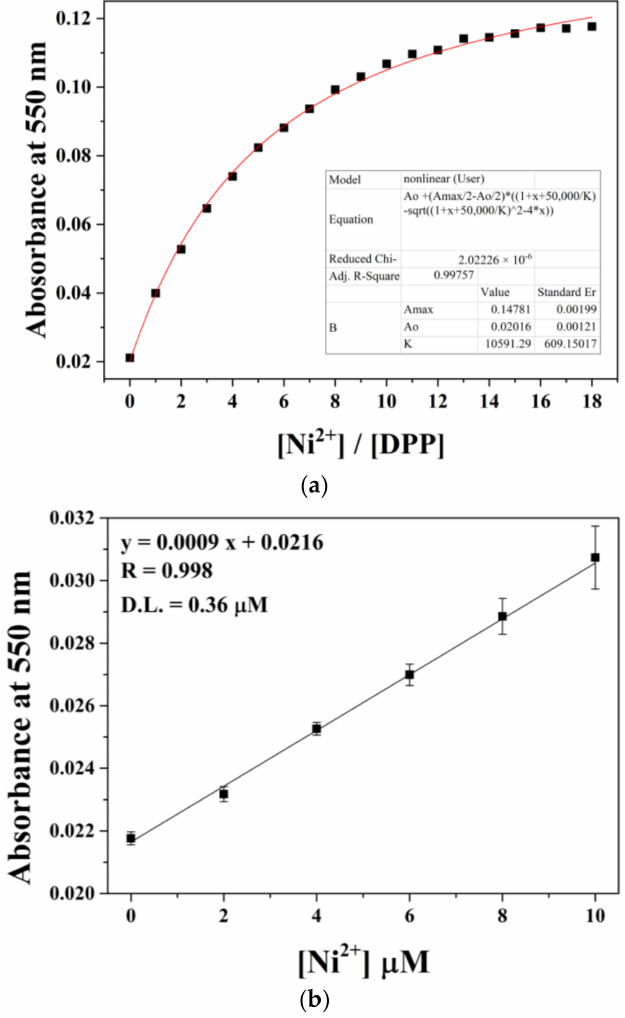
Figure 5. ( a ) Association constant based on variation in the ratio (absorbance at 550 nm) of DPP (20 µ M) with Ni 2+ . The Redline is the nonlinear fitting obtained, assuming a 1:1 binding of DPP and Ni 2+ . ( b ) Analysis of the detection limit for Ni 2+ by DPP (20 µ M). The standard deviations are represented by the error bar (n =